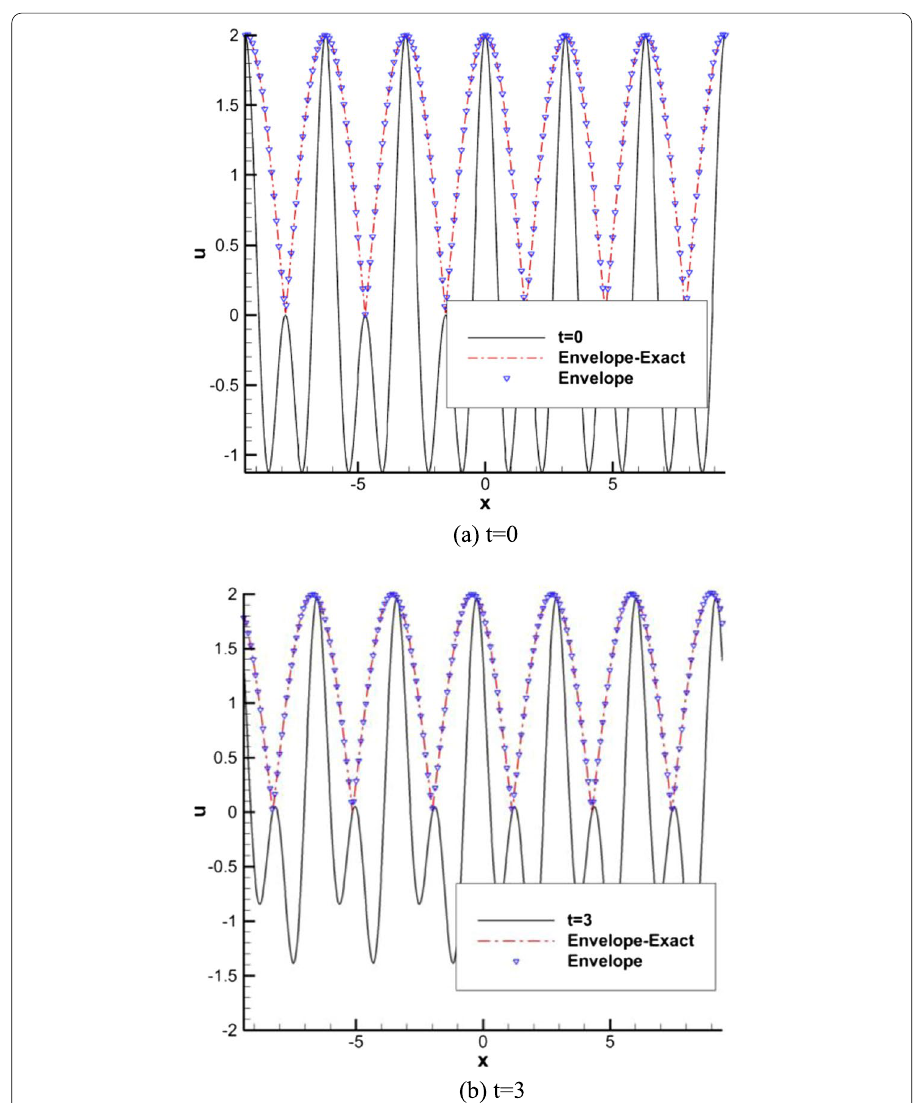
Fig. 12 Envelope of the distribution u